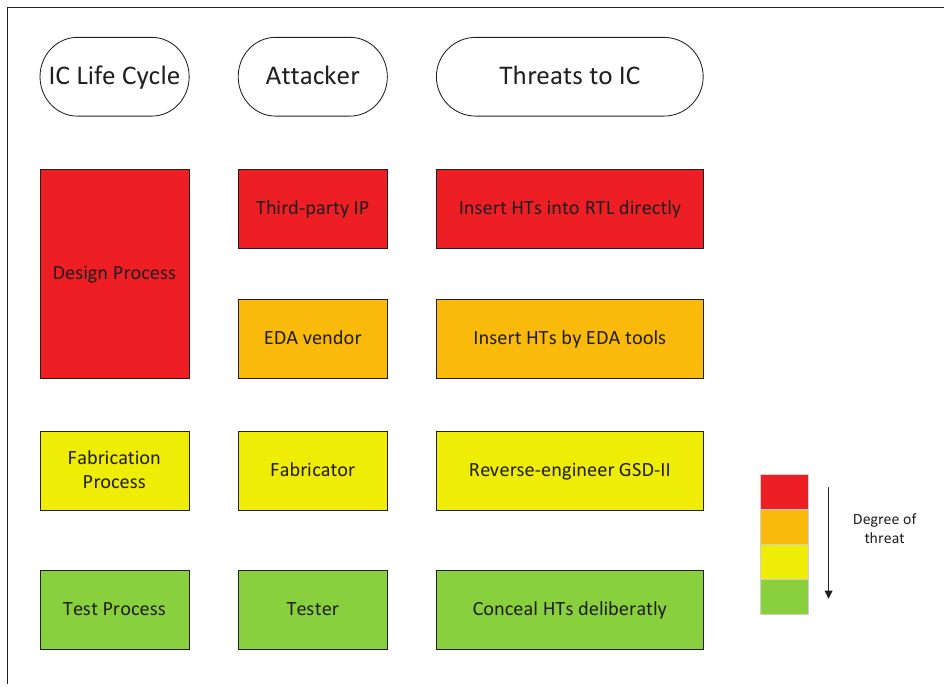
Figure 1. IC life